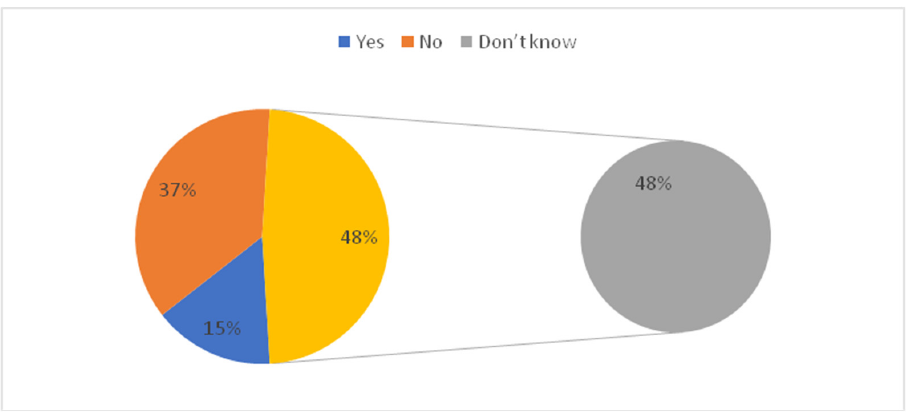
Figure 1. Parents expect that the COVID-19 vaccine affects child genes?